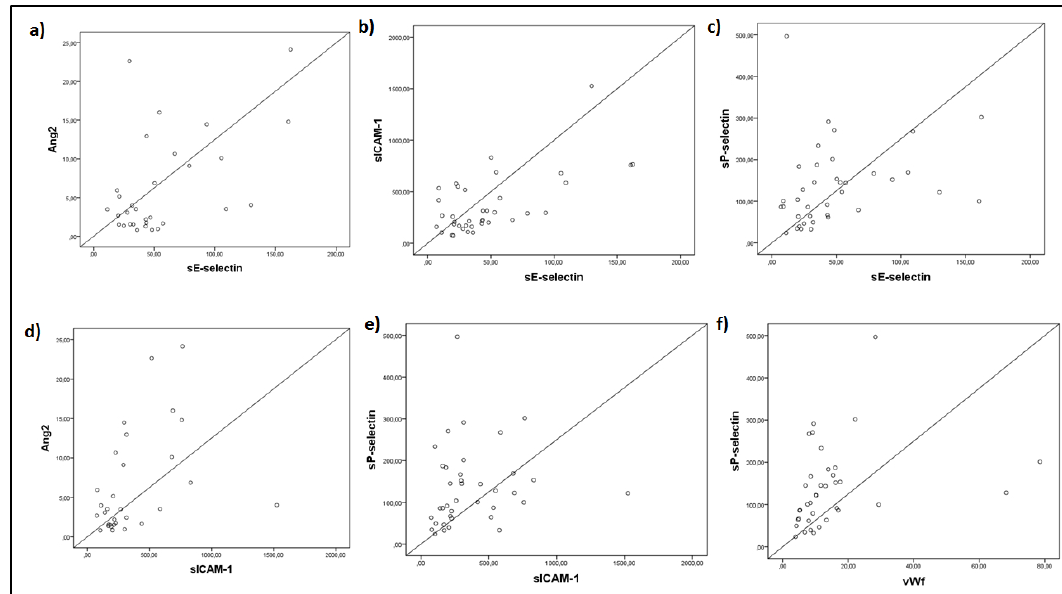
Figure 2. Spearman’s correlation coefficient analysis was performed on sE-selectin, sP-selectin, Ang-2, sICAM-1, and vWf levels measured upon intensive care unit (ICU) admission (within 24 h). ( a ) sE-selectin and Ang-2 (r s = 0.389, p = 0.031), ( b ) sE-selectin and sICAM-1 (r s = 0.686, p < 0.0001), ( c ) sE-selectin and sP-selectin (r s = 0.398, p = 0.013), ( d ) Ang-2 and sICAM-1 (r s = 0.545, p = 0.002), ( e ) sP-selectin and sICAM-1 (r s = 0.362, p = 0.026), and ( f ) sP-selectin and vWf (r s = 0.513, p = 0.001). Ang-2 = Angiopoietin-2; s = soluble; sICAM-1 = soluble intercellular adhesion molecule 1; vWf = von Willebrand